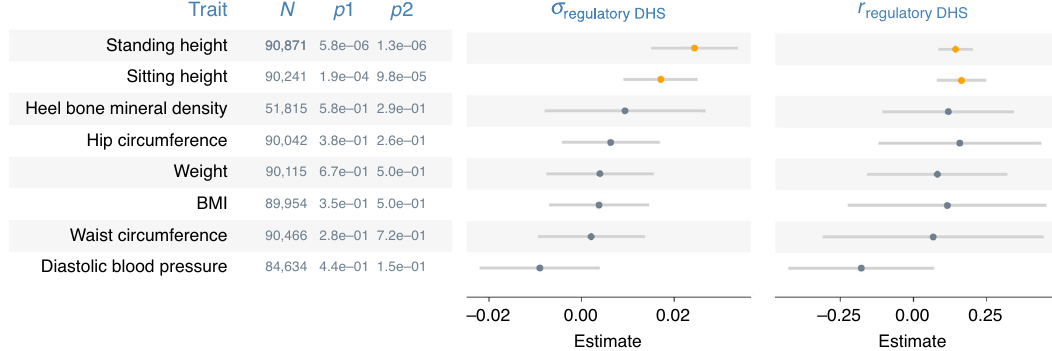
Fig. 3 Covariance estimates from genomic partitioning analyses. Shown are estimated covariance ( σ regulatoryDHS ) and correlations ( r regulatoryDHS ) between genetic effects attributable to the regulatory regions and those attributable to the DNase I hypersensitivity sites (DHS) on phenotypes. Error bars are 95% con fi dence intervals (based on s.e.m.). N = sample size; p 1 = p -values from likelihood ratio tests that compare GREML with CORE GREML to detect σ p 2 = p -values based on the Wald ’ s test statistic under the null hypothesis that r = 0 (i.e., a two-sided test). Highlighted in orange regulatoryDHS ; regulatoryDHS are signi fi cant σ regulatoryDHS and r regulatoryDHS after a Bonferroni adjustment for multiple comparisons. Fluid intelligence and years of education are excluded because either the random effects of the regulatory regions or those of the DHS on their phenotypes were not signi fi cant. Source data are provided as a Source Data fi